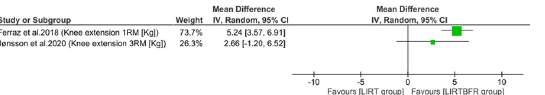
Fig 3. Forest plot of the comparison between LIRTBFR and LIRT on muscle strength assessed by knee extension (n = 2 studies). LIRTBFR: Low intensity resistance training combined with blood flow restriction; LIRT: Low intensity resistance training without blood flow restriction; 1RM: 1 maximum repetition; 3RM: 3 maximum repetition test; Kg: kilogram; I 2 : Heterogeneity of studies; SD: standard deviation; MD: mean difference; 95% CI: 95% confidence interval; IV: inverse variance; Random: random effects